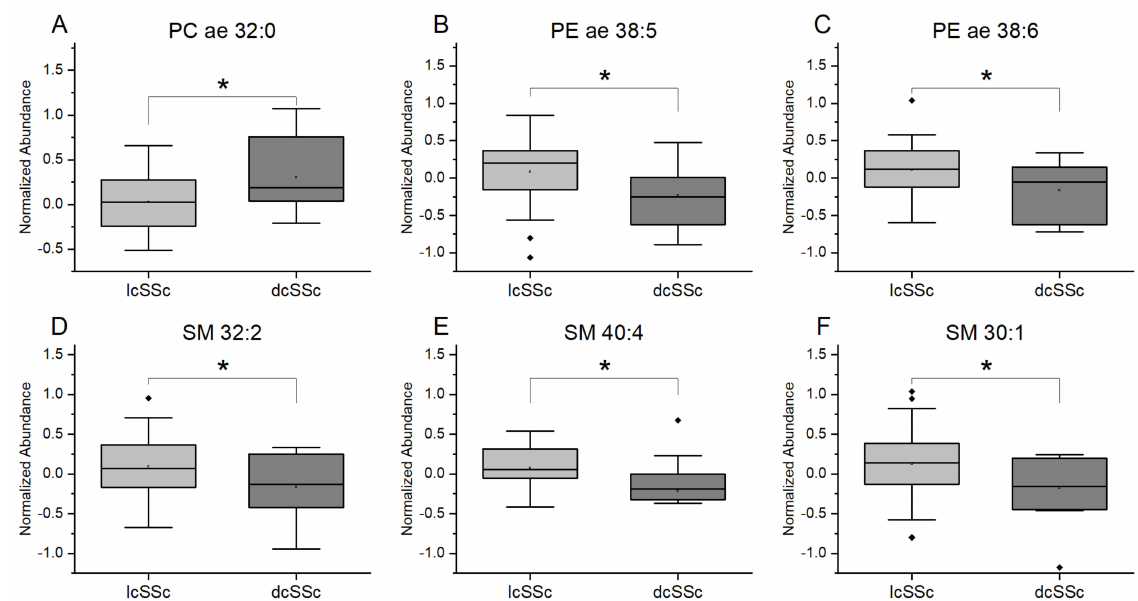
Figure 2. Differences in plasma levels of plasmalogens and sphingomyelins between dcSSC and lcSSc patients. Results of lipidomics measurements for ( A ) phosphatidylcholine PC ae 32:0, ( B ) phosphatidylethanolamine PE ae 38:5, ( C ) PE ae 38:6 and for ( D ) sphingomyelin SM 32:2, ( E ) SM 40:4 and ( F ) SM 30:1. Limited cutaneous systemic sclerosis, lcSSc ( n = 39), diffuse cutaneous systemic sclerosis, dcSSc ( n = 11). Data are expressed as normalized abundance. Resulting p -values from group comparisons were determined by a two-tailed Student’s t -test, and p < 0.05 was considered significant (* p <